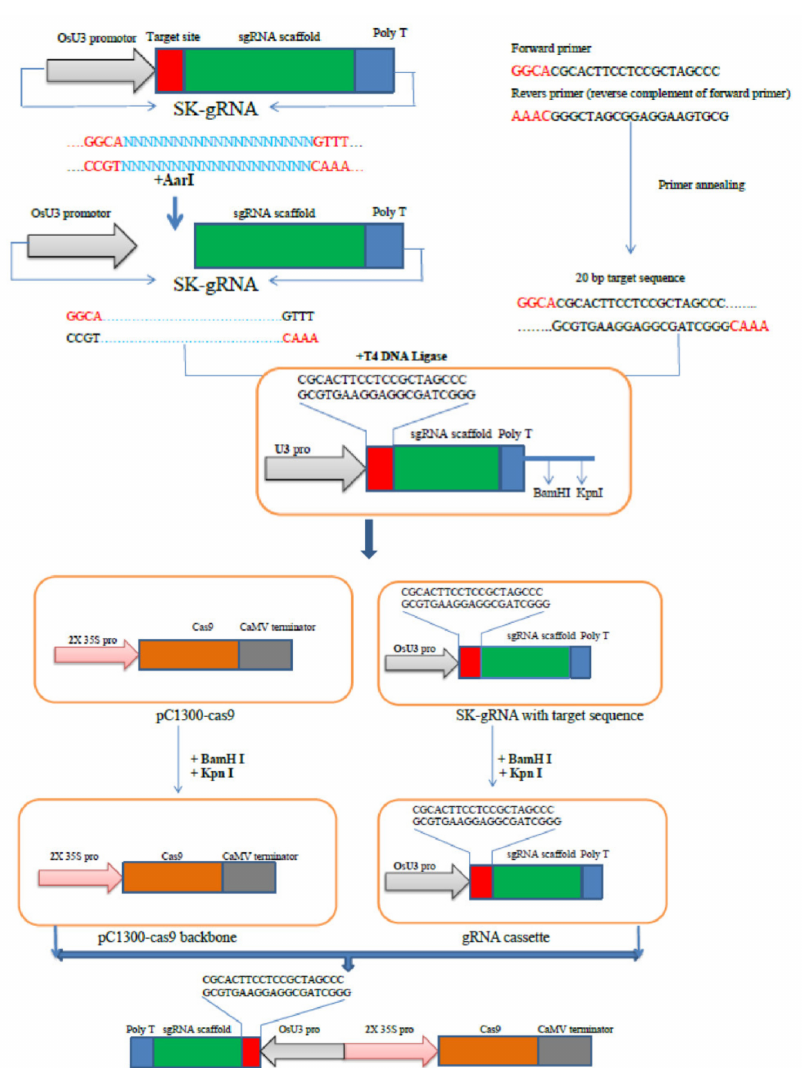
Figure 4. T-DNA vector with all the components necessary for Cas9-induced mutagenesis. The 20 bp protospacer sequences of each target site are subcloned or integrated between the sgRNA scaffold and the U3 promoter by ligation of primers into an AarI -digested SK-sgRNA vector. Then, this vector is again re-ligated with a pC1300-Cas9 vector by ligation of BamHI and KnpI -digested enzymes. The whole sgRNA cassette is then delivered into a pC1300-Cas9 vector (contains the Cas9 gene under the control of the 2 × 35S promoter) for plant